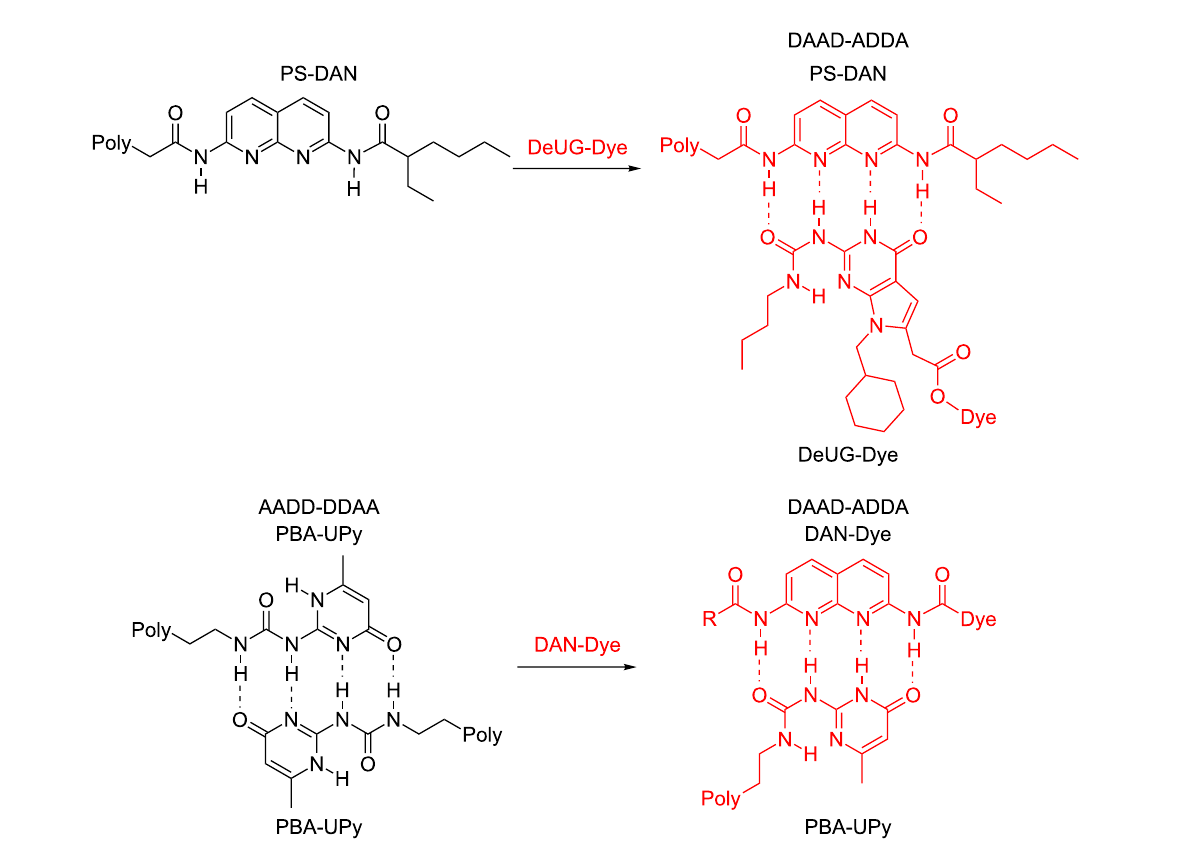
Figure 2: Illustration of the use of DeUG-Dye and DAN-Dye as colorimetric indicators for supramolecular interactions through specific quadruply hydrogen-bonding interactions. Top: DeUG-Dye interacts with DAN modified polystyrene (PS). Bottom: DAN-Dye interacts with UPy modified poly- butyl acrylate